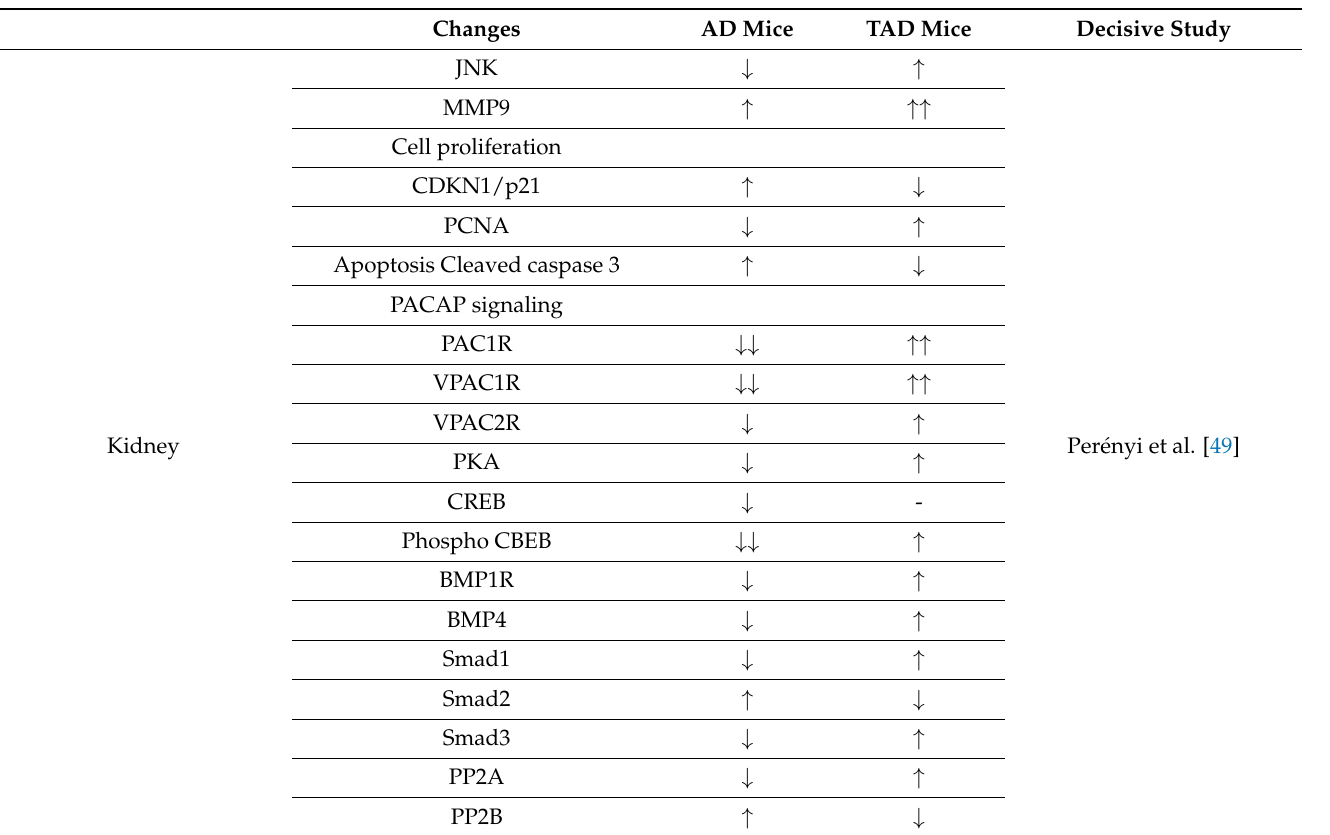
Table 1. Cont. Changes AD Mice TAD Mice Decisive